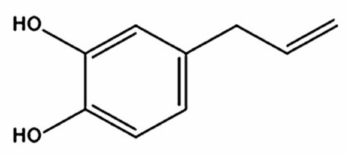
Figure 1. Chemical structure of 4-Allylpyrocatechol